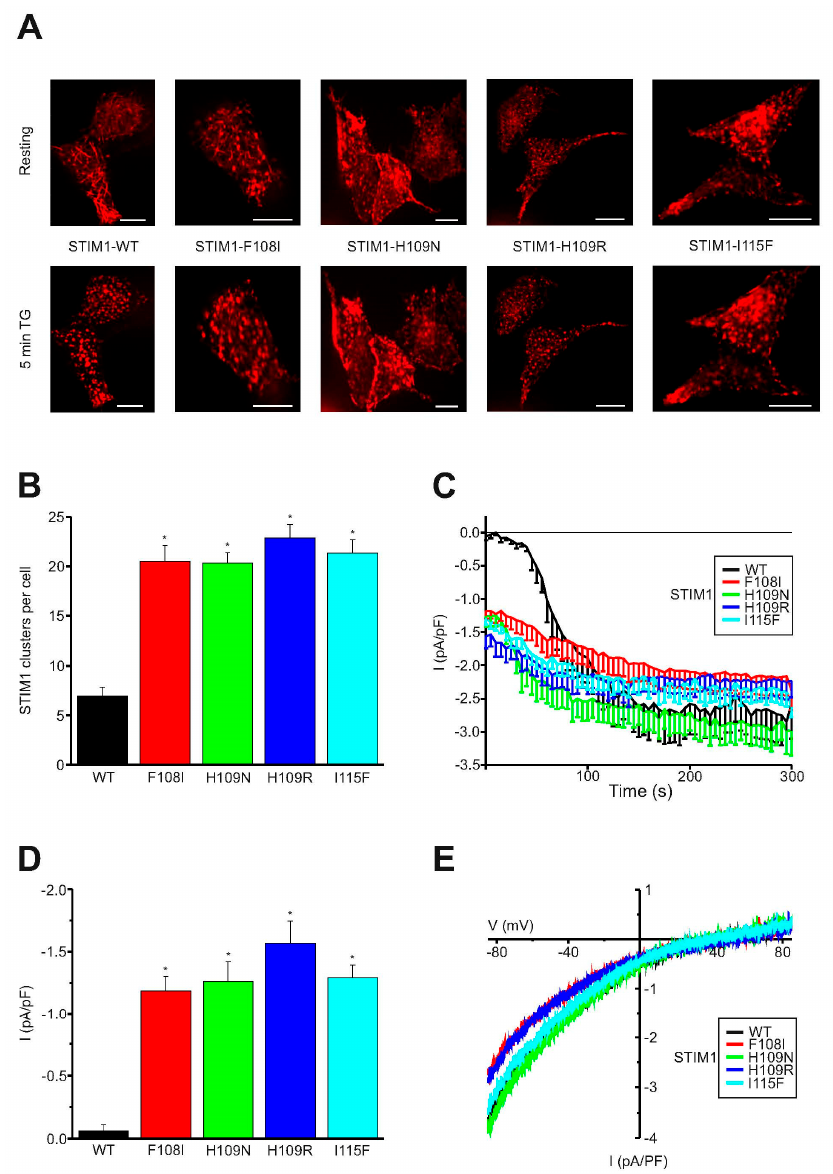
Figure 3. STIM1 non-canonical EF-hand mutants constitutively activate CRAC channel currents. ( A ) Representative example images of cells expressing YFP-tagged STIM1 wild type, STIM1-F108I, STIM1-H109N, STIM1-H109R, or STIM1-I115F under resting-state conditions and after treatment with 1 µ M thapsigargin (TG) for 5 min. Scale bar 10 µ m. ( B ) Mean value of STIM1 cluster formation per cell during resting cell conditions for wild type STIM1, STIM1-F108I, STIM1-H109N, STIM1-H109R, and STIM1-I115F ( n = 22 to 39 cells per mutant). An asterisk (*) indicates a significant di ff erence in the number of STIM1 clusters between STIM1 mutants and STIM1 wild type in the resting state ( t -test: p < 0.01)). ( C ) Time course of whole-cell patch-clamp average currents at − 86 mV from cells overexpressing STIM1 wild type, STIM1-F108I, STIM1-H109N, STIM1-H109R, and STIM1-I115F. Intracellularsolutioncontaining20mMEDTApassivelyinducedstoredepletion. ( D )Meancurrentsafter whole-cell break-in ( n = 7 to 12 cells per mutant, data were taken from three independent transfections). An asterisk (*) indicates a significant di ff erence in whole-cell break-in currents between STIM1 mutants and STIM1 wild type in the resting state ( t -test: p < 0.01). ( E ) Representative current / voltage relationships according to whole-cell patch-clamp experiments with cells overexpressing STIM1 wild type, STIM1-F108I, STIM1-H109N, STIM1-H109R, and STIM1-I115F,